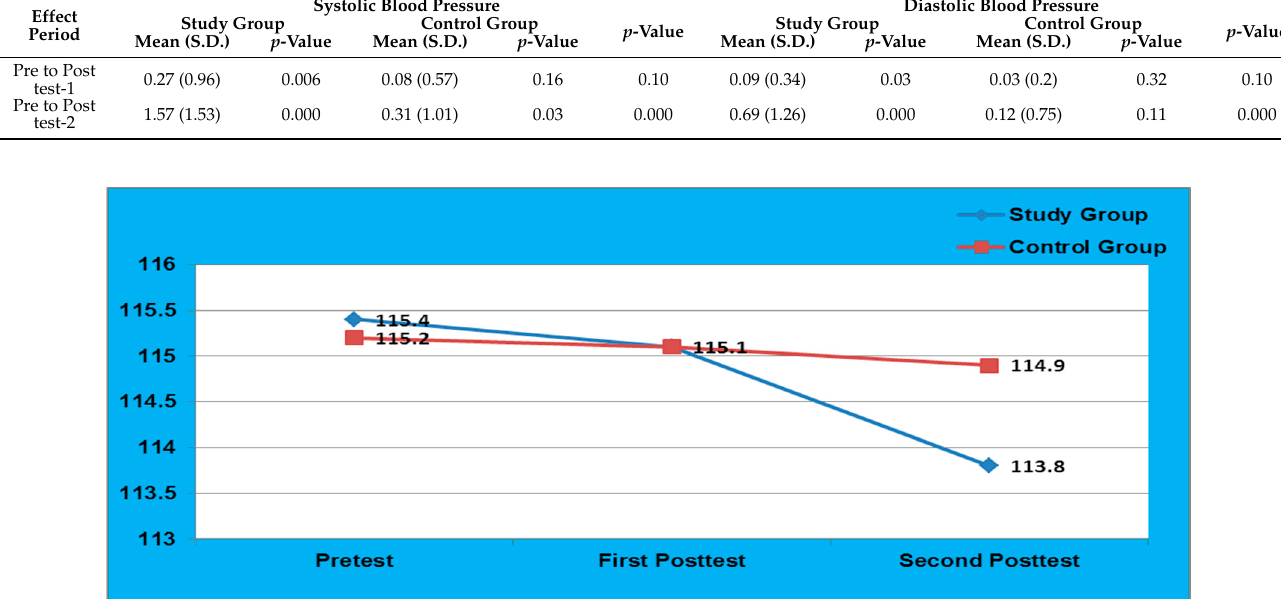
Figure 2. Comparison of SBP among Study and Control Group.